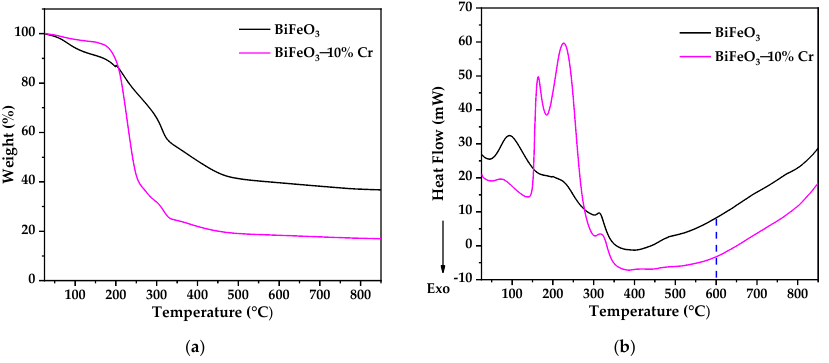
Figure 1. Thermal study of pure and doped BiFeO 3 through ( a ) Thermogravimetric analysis and ( b ) Differential Scanning Calorimetry.